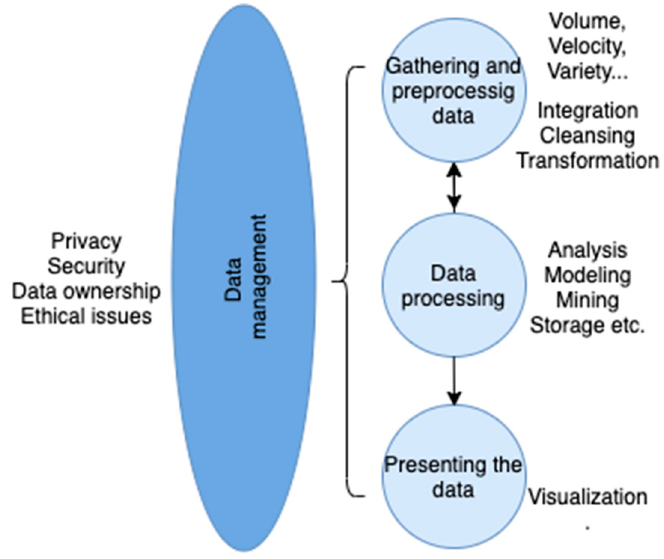
Figure 4. Conceptual classification of big data challenges. Source: based on Sivarajah et al. [151].